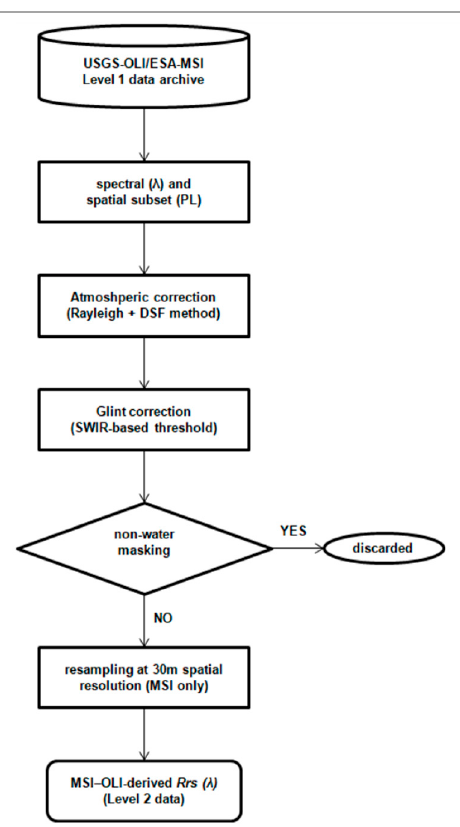
Figure 4. Rrs ( λ ) Level 2 data-processing flowchart.